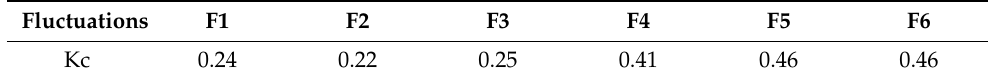
Table 5. Contour tortuosity data for each wave.